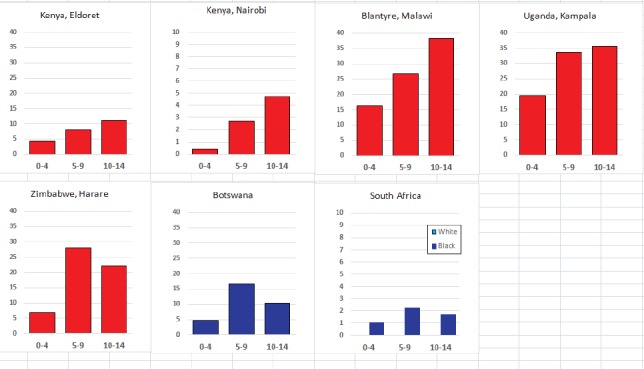
Age-specific histograms—Kaposi sarcoma.